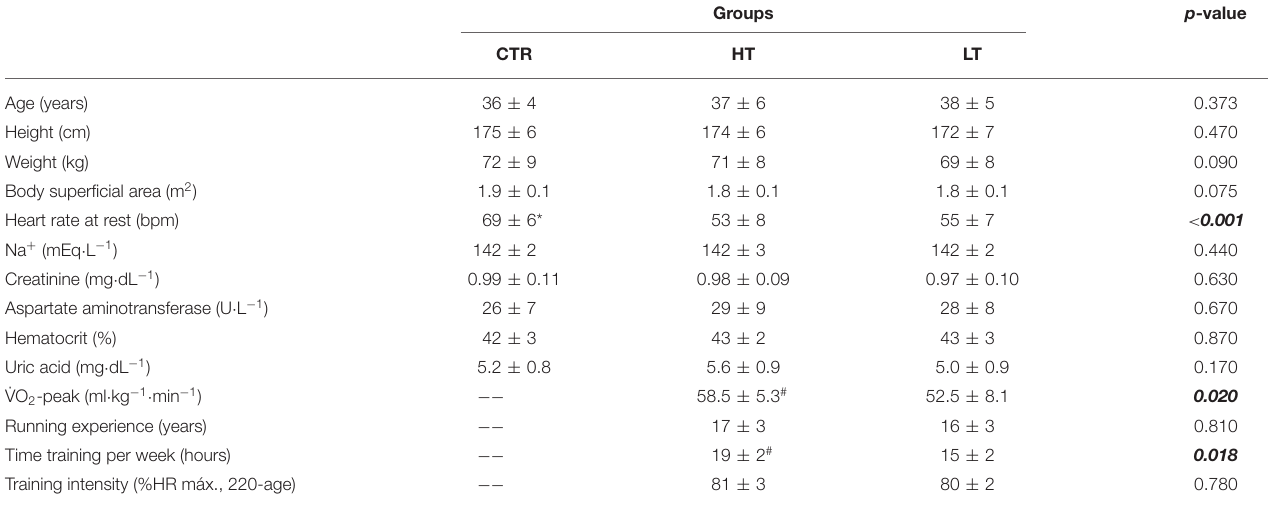
TABLE 1 | Characteristics of the participants.